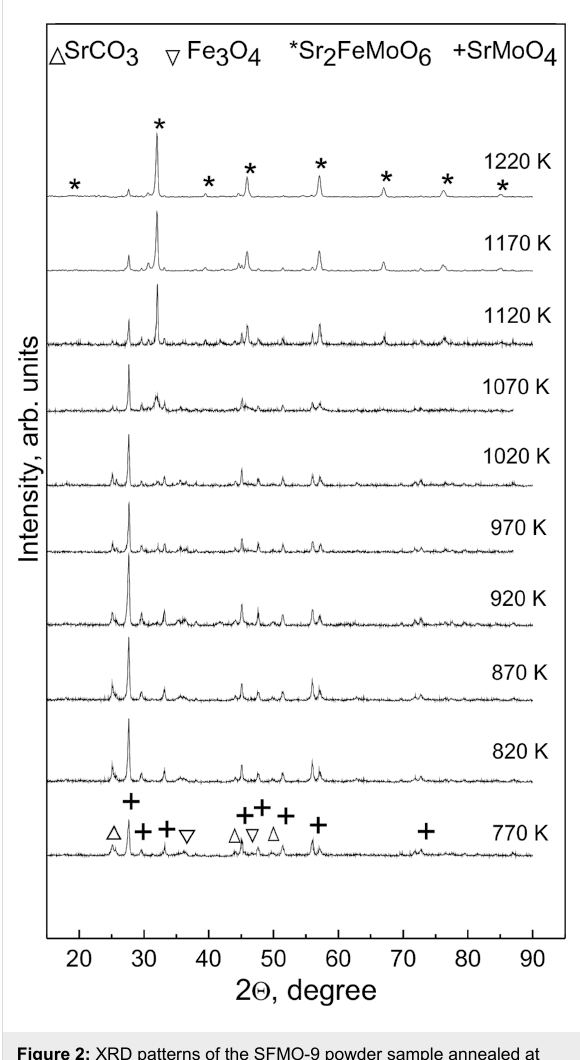
Figure 2: XRD patterns of the SFMO-9 powder sample annealed at 770–1270 K with a 2 K/min heat rate in a continuous stream of 5% H 2 /Ar gas